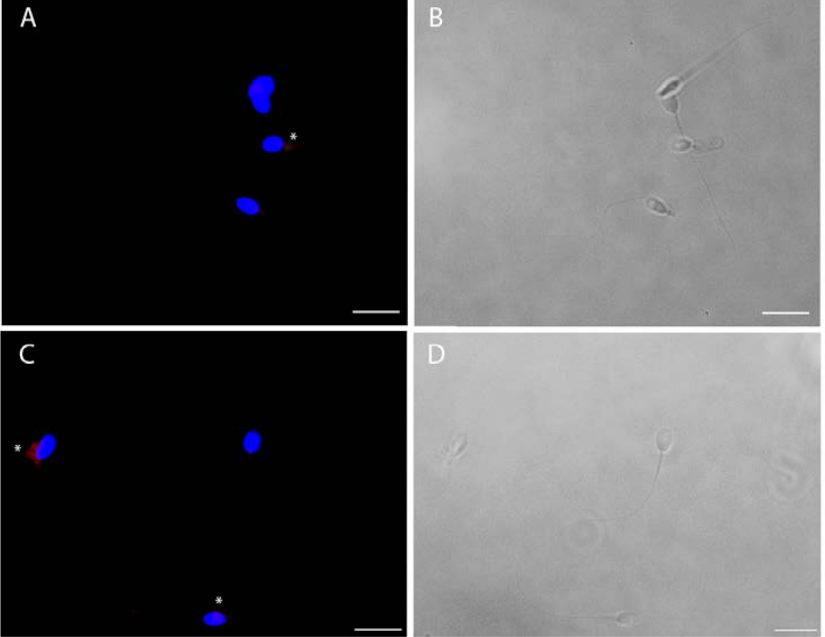
Figure 5. Intracellular immunofluorescence localization of SARS-CoV-2 nucleocapsid ( A ) and spike ( C ) proteins and bright filed images (respectively B and D ) of ejaculated human sperm in vitro infected by SARS-CoV-2. The fluorescent staining is localized in the cytoplasmic residues at the midpiece level (asterisks). Nuclei were counterstained with 4,6-diamino-2-phenylindole (DAPI) (blue). Scale bar = 5 µm.